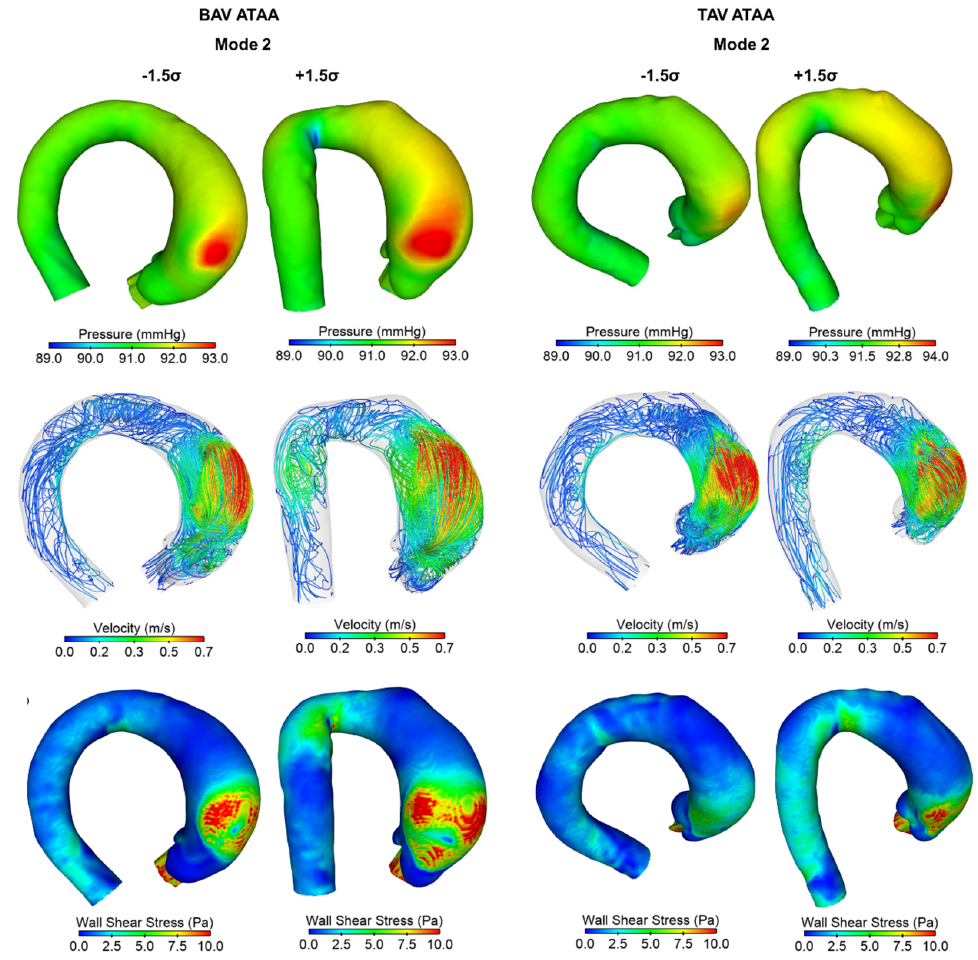
Figure 7. Pressure ( top ), flow velocity ( center ), and WSS ( bottom ) for BAV and TAV ATAA models for Mode 2 at ±1.5 σ .